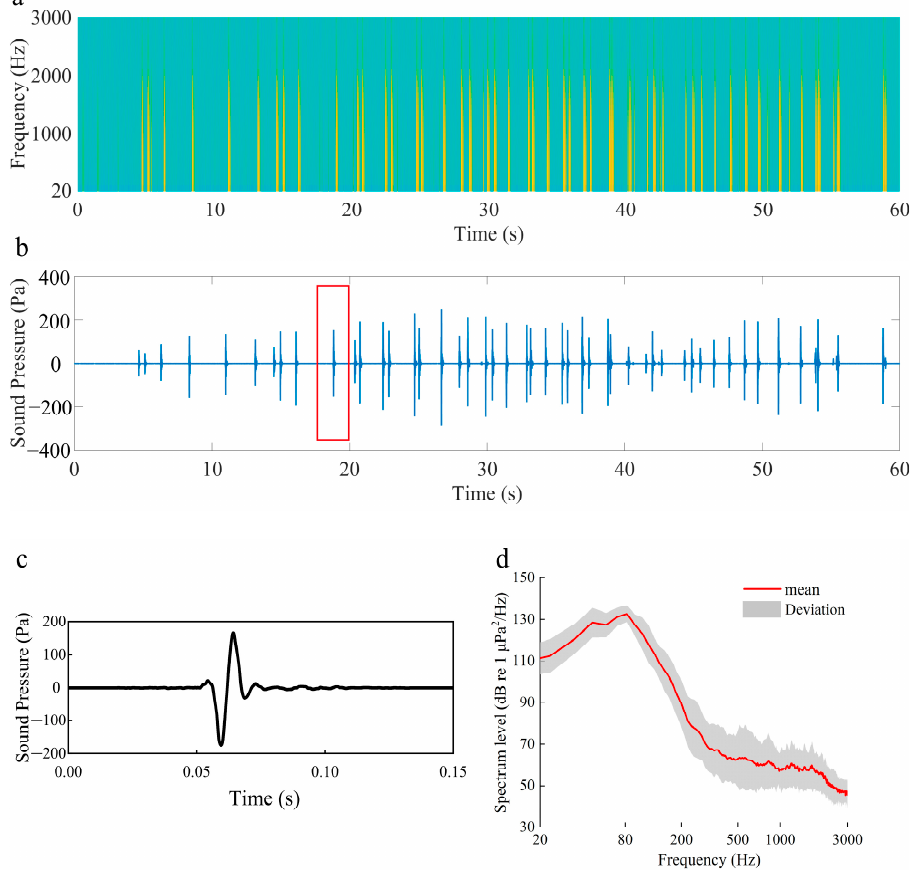
Figure 2. Spectrogram ( a ) and oscillogram ( b ) of representative single drum trains emitted by Chinese bahaba. ( c ) Oscillogram for representative individual single drum and ( d ) power spectra for the total calling signals.